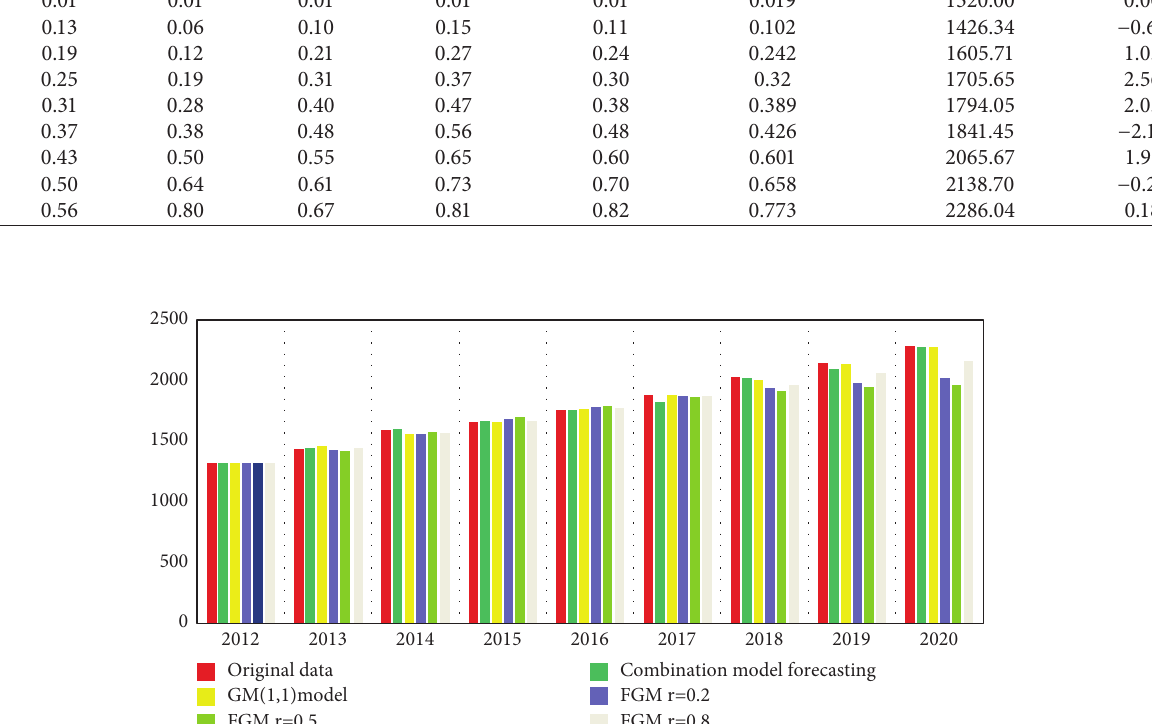
Table 6: Comparison of the two data between the combination model and the original data. Tian. r � 1 Year